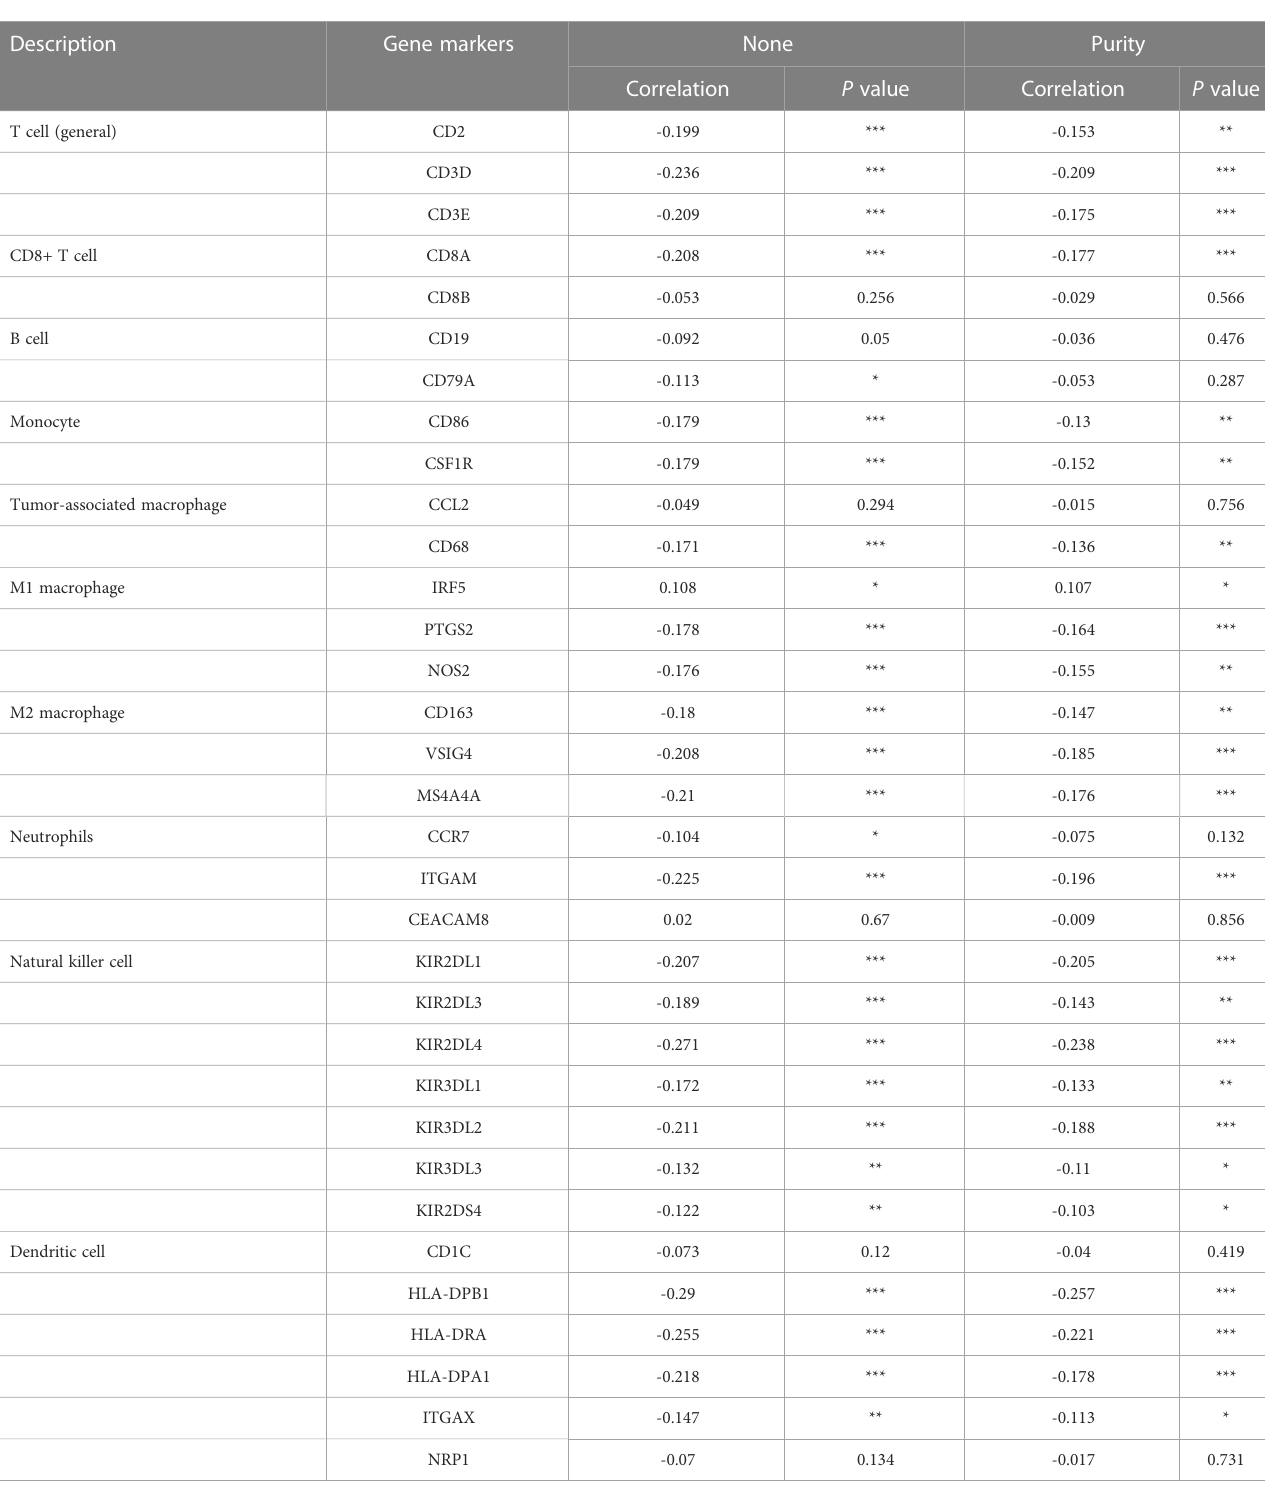
TABLE 1 Correlation analysis between TOMM34 and gene markers of immune cells in